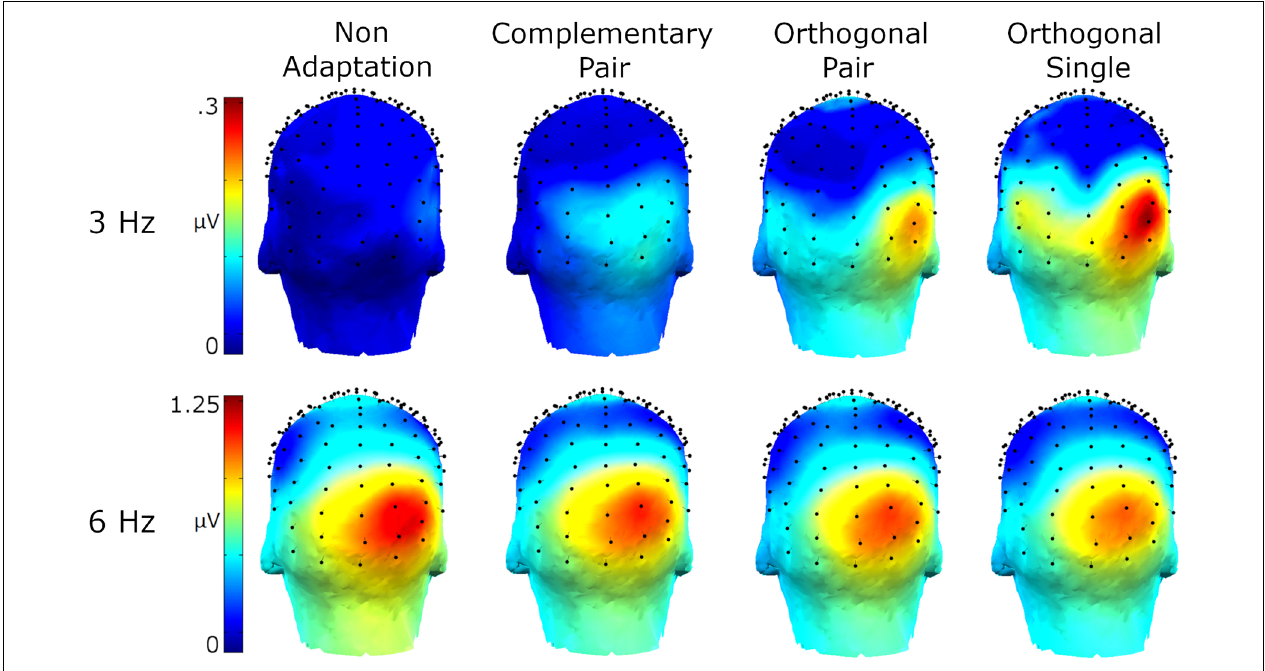
FIGURE 3 | Head maps showing baseline subtracted amplitudes at 3 Hz and 6 Hz for the four conditions.